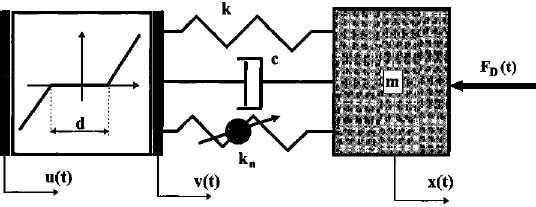
Fig. 8. Dynamic system, used in the numerical experiments.